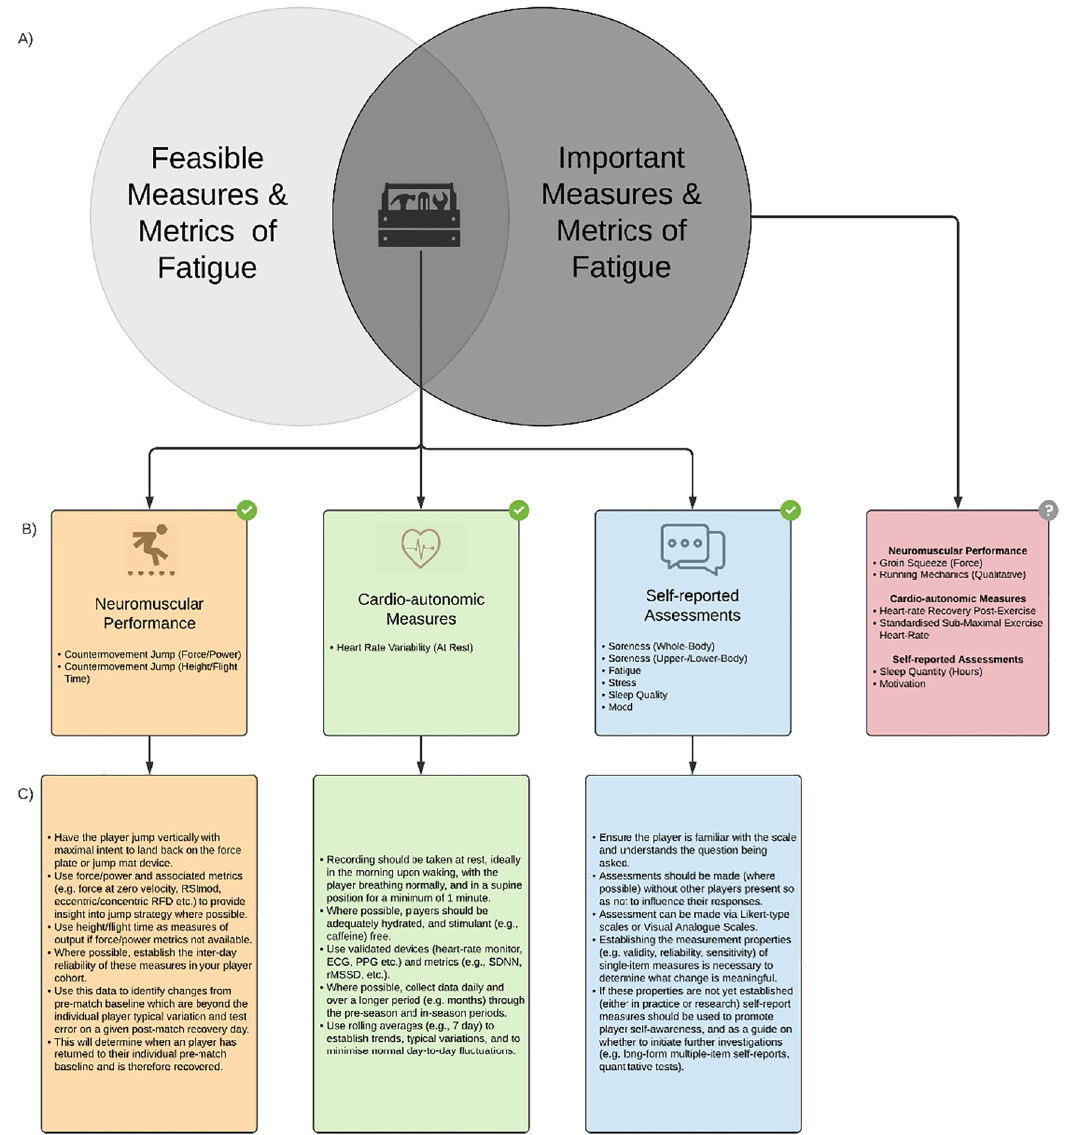
Fig 6. A graphical representation of a post-match player fatigue monitoring system based on SME ratings for A) important and feasible measures and metrics. The fatigue monitoring system includes B) a ‘toolbox’ of items that achieved consensus and rated highly ( � 3/5) for importance and feasibility to implement in the rugby football codes for objective (i.e. neuromuscular performance [32–34], cardio-autonomic [35, 36]), and subjective (i.e. self-report assessment [5, 37, 38]) domains. Items which achieved consensus and rated highly for importance but not for feasibility to implement are represented by the arrow linking to the box to the right of the Venn diagram. Included within the graphical representation are C) considerations for testing and analysing data for the domains of these measures and metrics (see [5, 32, 33, 35–40] for further assessment considerations. ECG—echocardiogram, PPG— photoplethysmography, rMSSD—square root of the mean sum of the squared differences in R-R intervals, RFD—rate of force development, RSImod—reactive strength index modified, and SDNN—standard deviation of all normal-to-normal